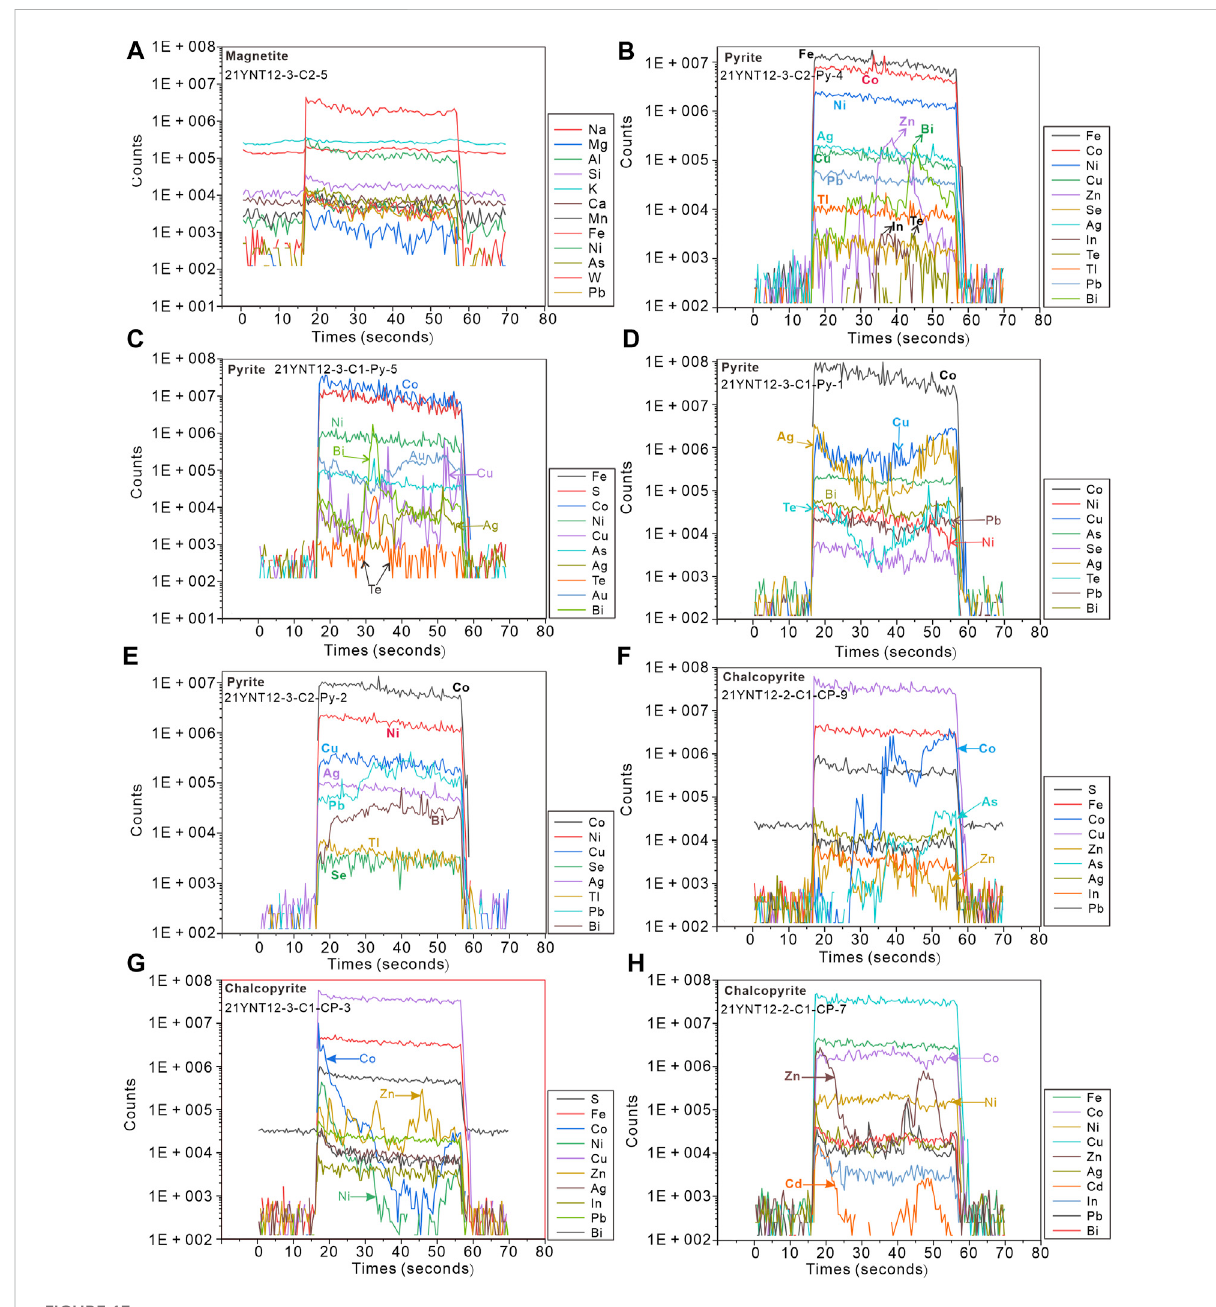
FIGURE 13 Representative time-resolved LA – ICP – MS depth pro fi les for magnetite (A) , pyrite (B – E) and chalcoprite (F – H)